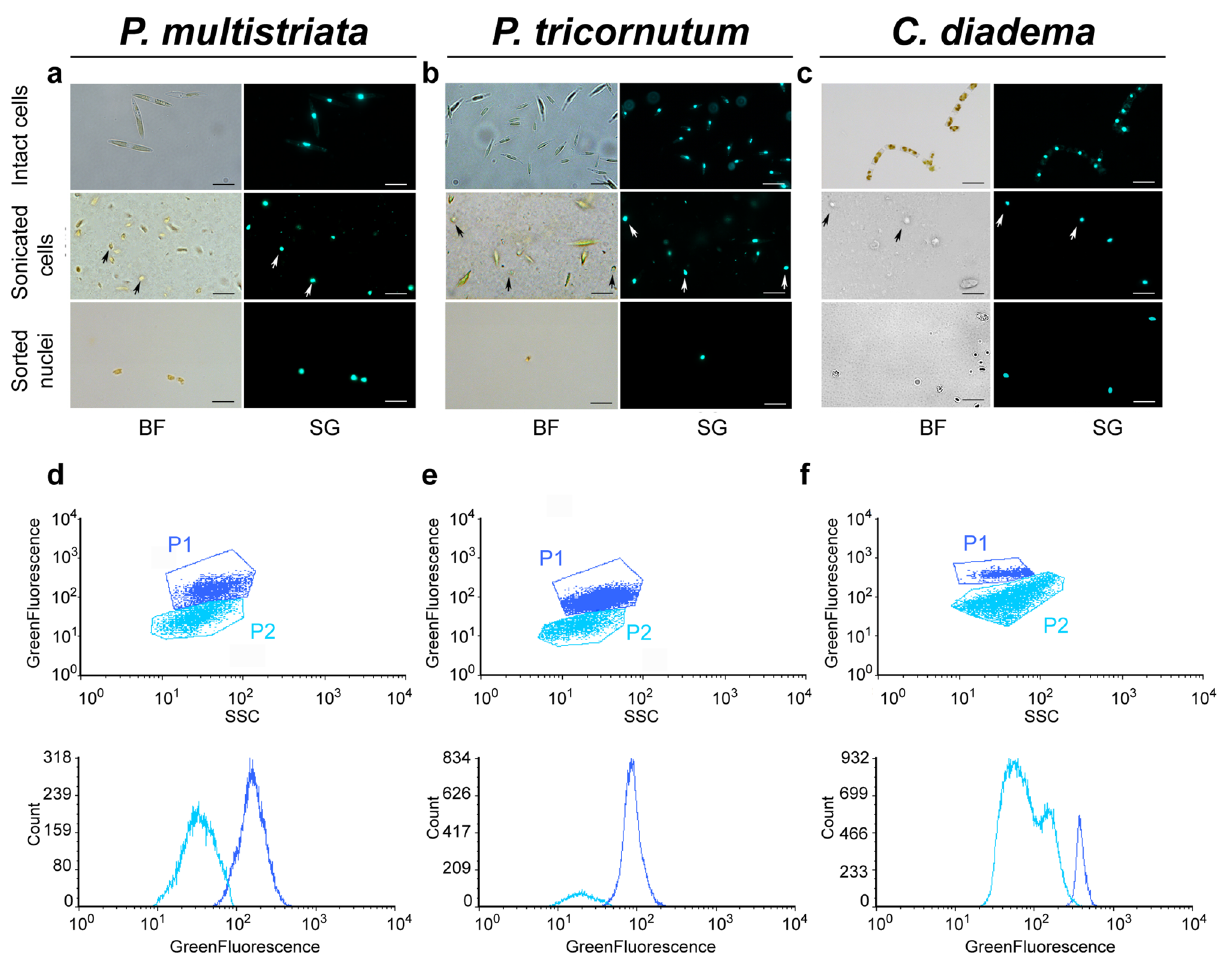
Figure 1. Isolation of intact nuclei from Pseudo-nitzschia multistriata , Phaeodactylum tricornutum , and Chaetoceros diadema . Bright-field and fluorescent microscopy images of intact cells, sonicated cells and sorted nuclei for P. multistriata ( a ), P. tricornutum ( b ) and C. diadema ( c ), scale bar 5 μm. Dot plots (up) and histograms (down) of flow cytometry analysis for nuclei isolation in P. multistriata ( d ), P. tricornutum ( e ) and C. diadema ( f ). In dark blue P1 indicates the gate containing extracted nuclei; in light blue P2 indicates the gate containing cellular residues. White and black arrows point to extracted nuclei. BF (Bright Field), SG (SYBR Green I), SSC (Side-Scatter). Graphs in ( d ), ( e ) and ( f ) were drawn with FCS Express 6 Flow v 6.06.0025, DeNovo Software,